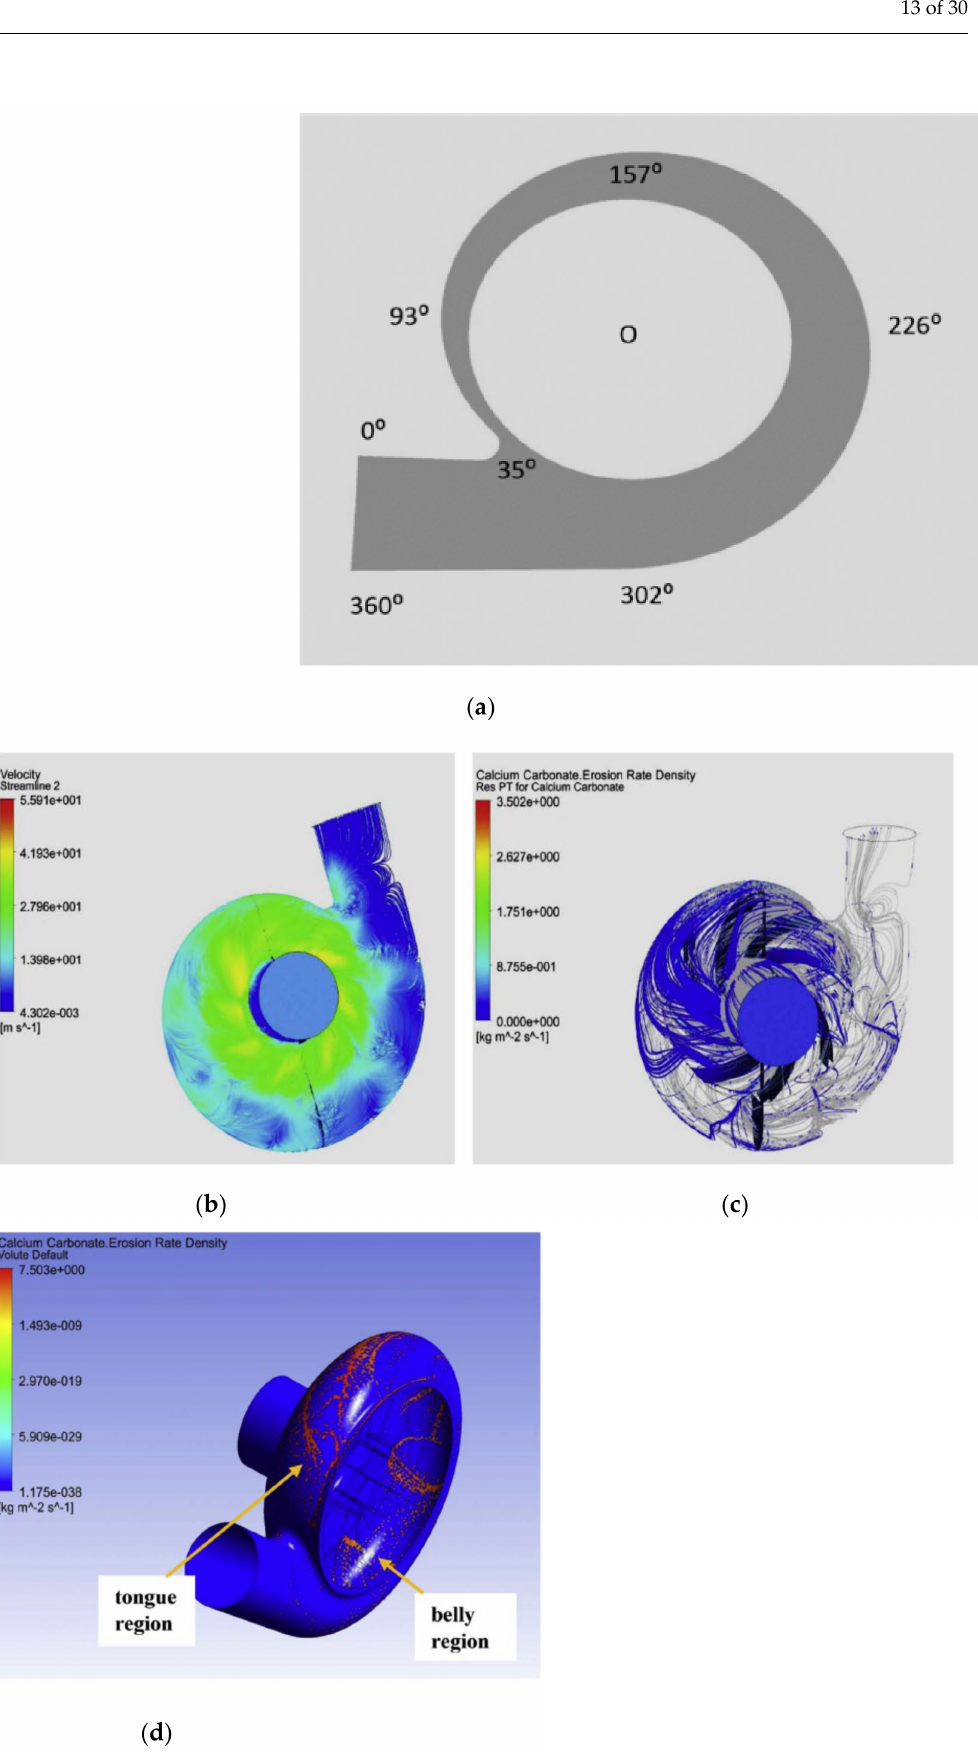
Figure 10. ( a ) Wear map generated for erosion identification ( b ) velocity streamlines, ( c ) particles tracking and ( d ) erosion loss